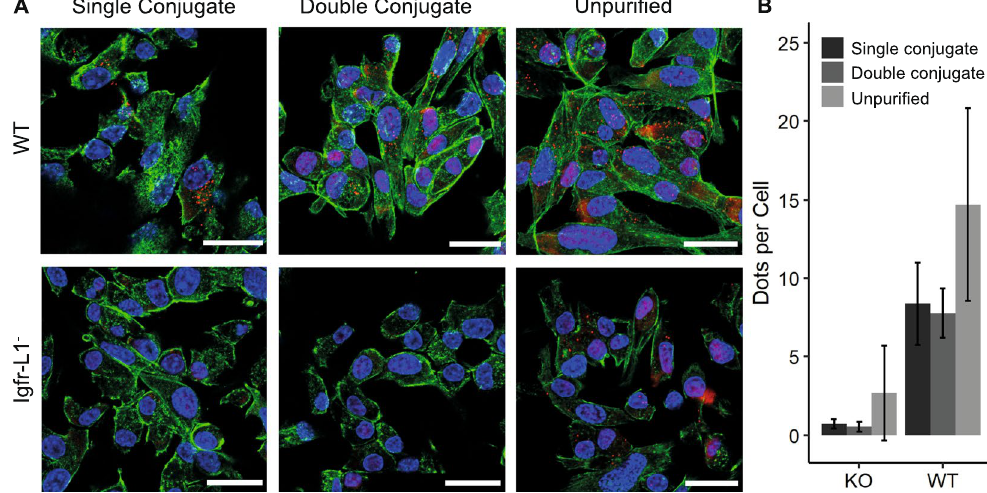
Figure 5. Proximity ligation assay (PLA) with purified single and double oligonucleotide-conjugated antibodies compared to unpurified oligonucleotide-conjugated antibodies. ( A ) Fluorescence images of wild type Min6 cells with PLA dots (red) generated by targeting the homodimer receptor Igfr-L1. Nucleus and actin cytoskeleton of the Min6 cells were counterstained with DAPI (blue) and phalloidin (green). Scale bar: 20 µ m. ( B ) PLA dot counts per cell to the corresponding fluorescence images in A. Samples size: 8180 cells. Error bars represent standard deviation.